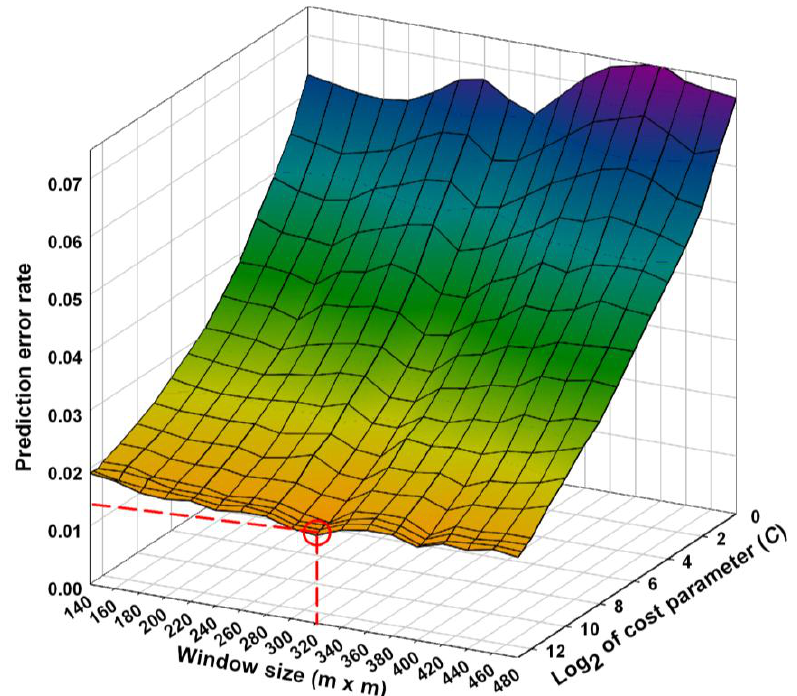
Figure 2. The prediction error rate (z-axis), estimated using fivefold cross-validation, as a function of varying the moving window size for averaging the lidar returns (x-axis) and the log2 of the cost parameter C (y-axis). As indicated by the red circle and the red dotted lines, the minimum prediction error rate of ≈ 0.015 was attained with a window size of 320 × 320 m and C = 7,000. The prediction error rates for window sizes less than 140 × 140 m were all higher than those for the window sizes shown on the figure and, thus, were omitted for clarity.